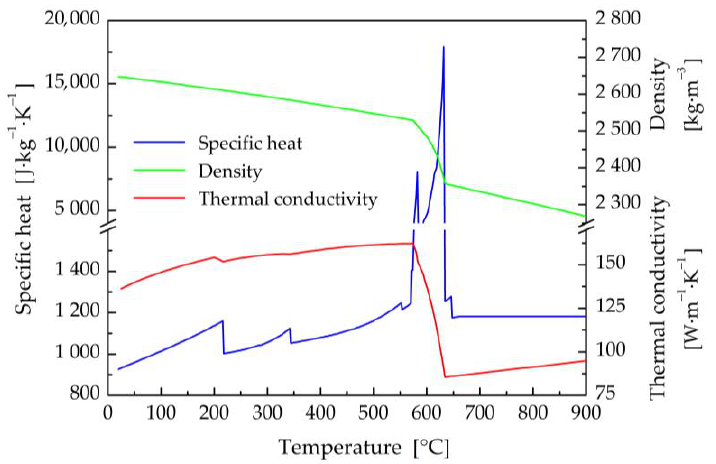
Figure 3. Thermal properties of the EN AW5083-H111 alloy in dependence on temperature.